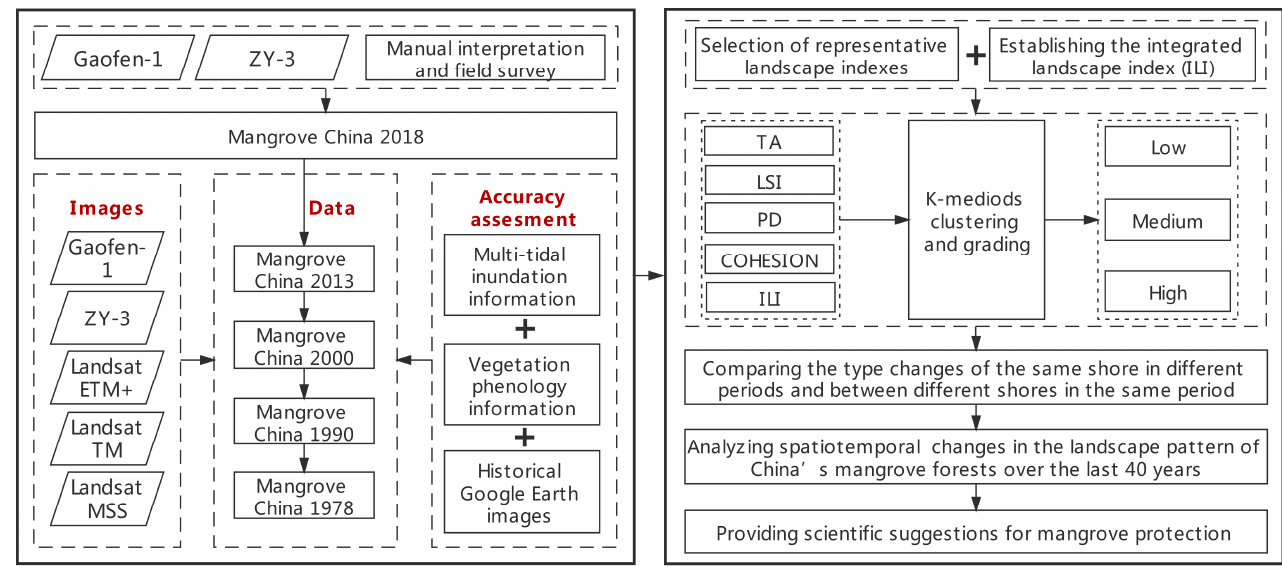
Figure 1. Workflow of this study.